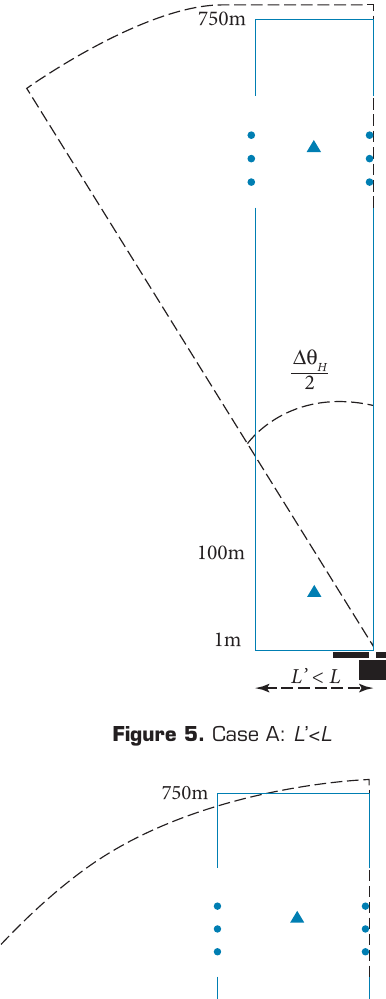
Figure 5. Case A: L ’< L